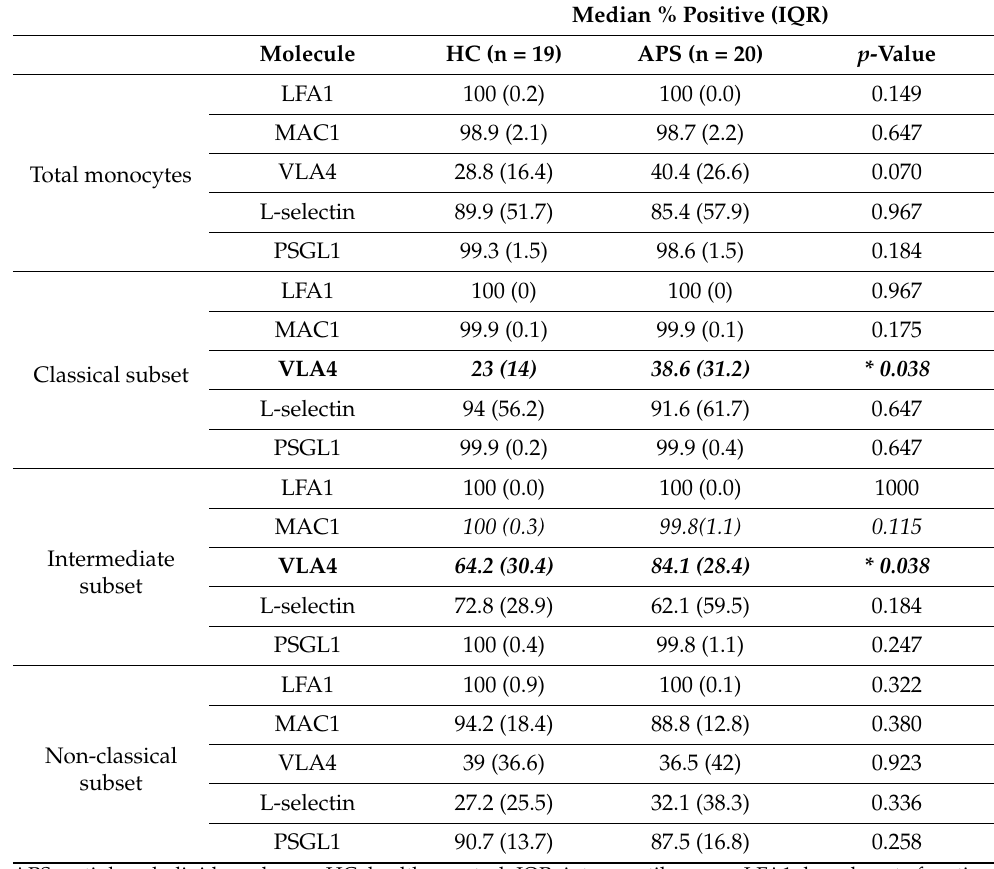
Table 2. The surface expression of adhesion molecules on circulating peripheral blood monocytes in APS patinets and HCs expressed as percentage of positive cells